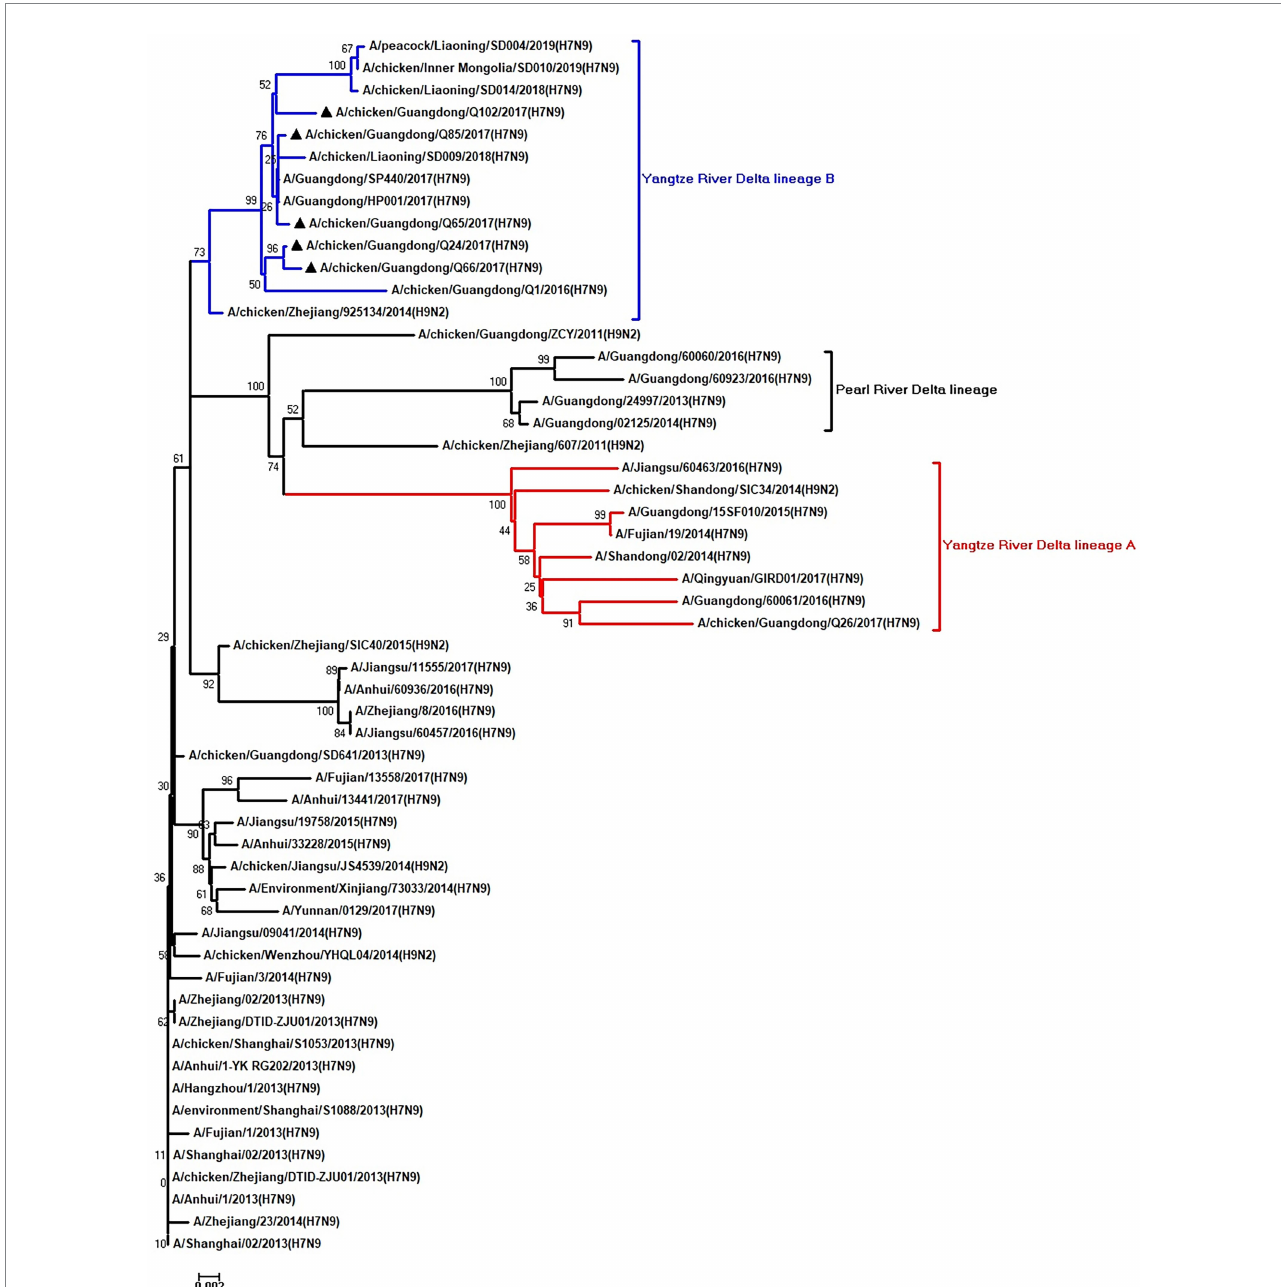
FIGURE 7 Phylogenetic analysis of NP. The tree was constructed by using the neighbor joining method with the Maximum Composite Likelihood model and MEGA version 5.2 (www.megasoftware.net/) with 1,000 bootstrap replicates based on the following sequences: NP: nt 46–1,542. Except our five isolates, other virus sequences were downloaded from GenBank. Triangles indicate the viruses characterized in this study. The scale bar indicates the branch length and corresponds to 0.002 estimated amino acid substitutions per